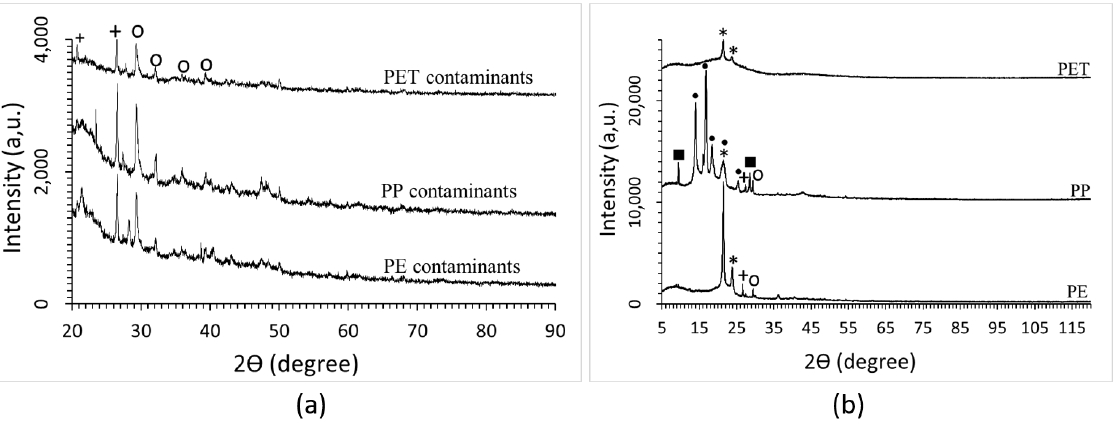
Figure 1. XRD of contaminants ( a ) and polymeric fractions ( b ): o = CaCO 3 , ■ = Mg 3 Si 4 O 10 (OH) 2 , + = SiO 2 , * = HDPE, • =